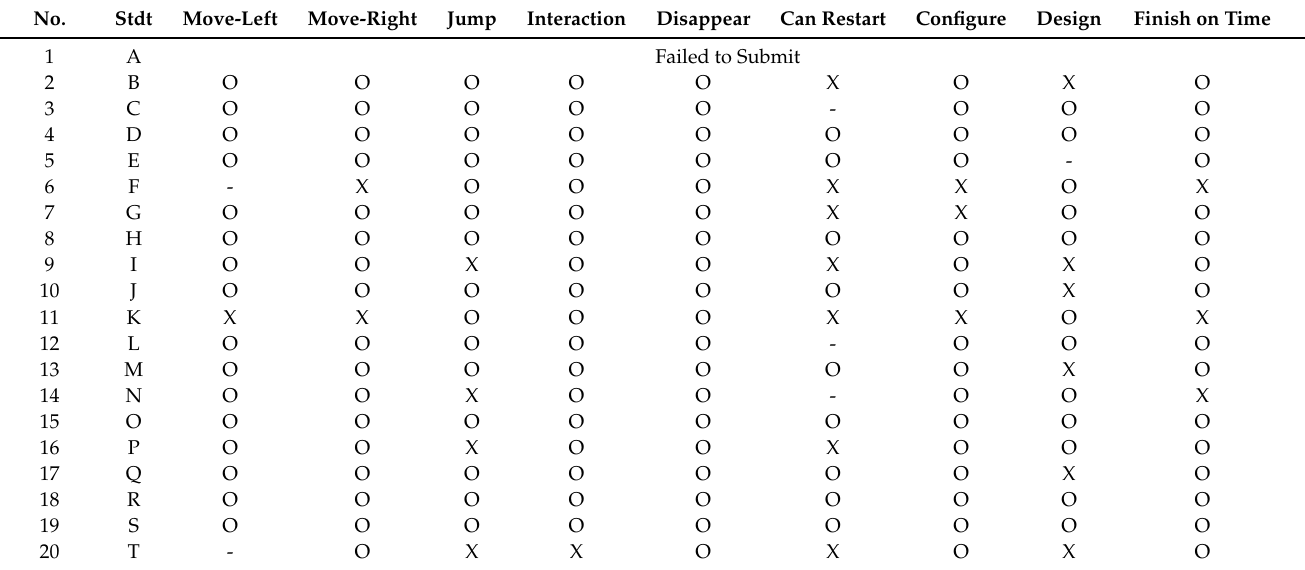
Table 2. Results of project activities of students who participated in the experiment.